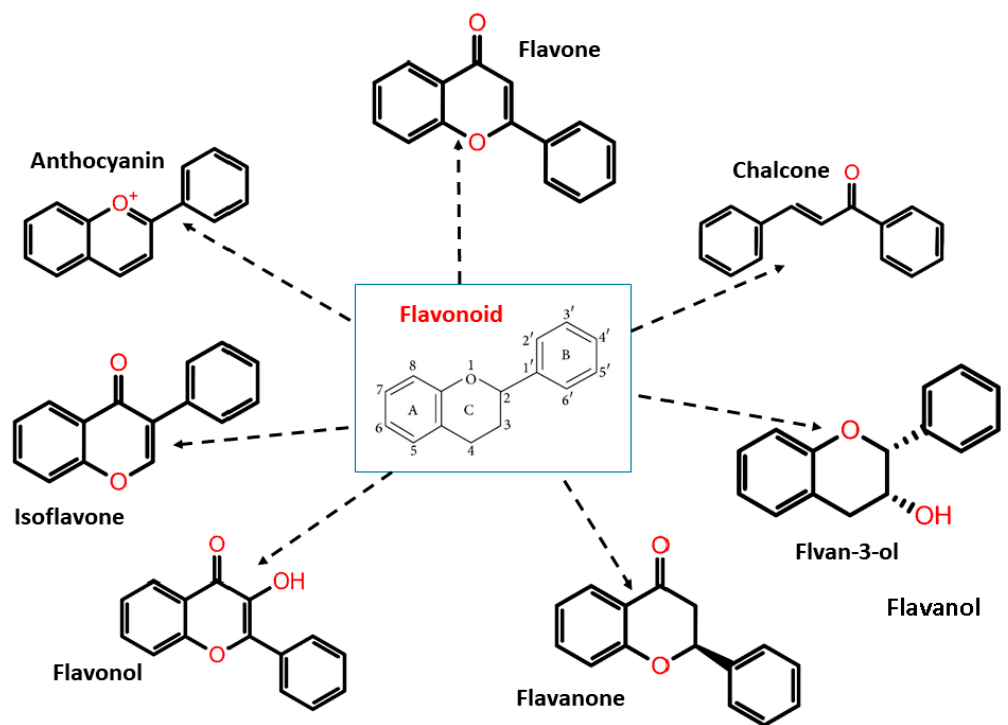
Figure 2. Flavonoid classification with its